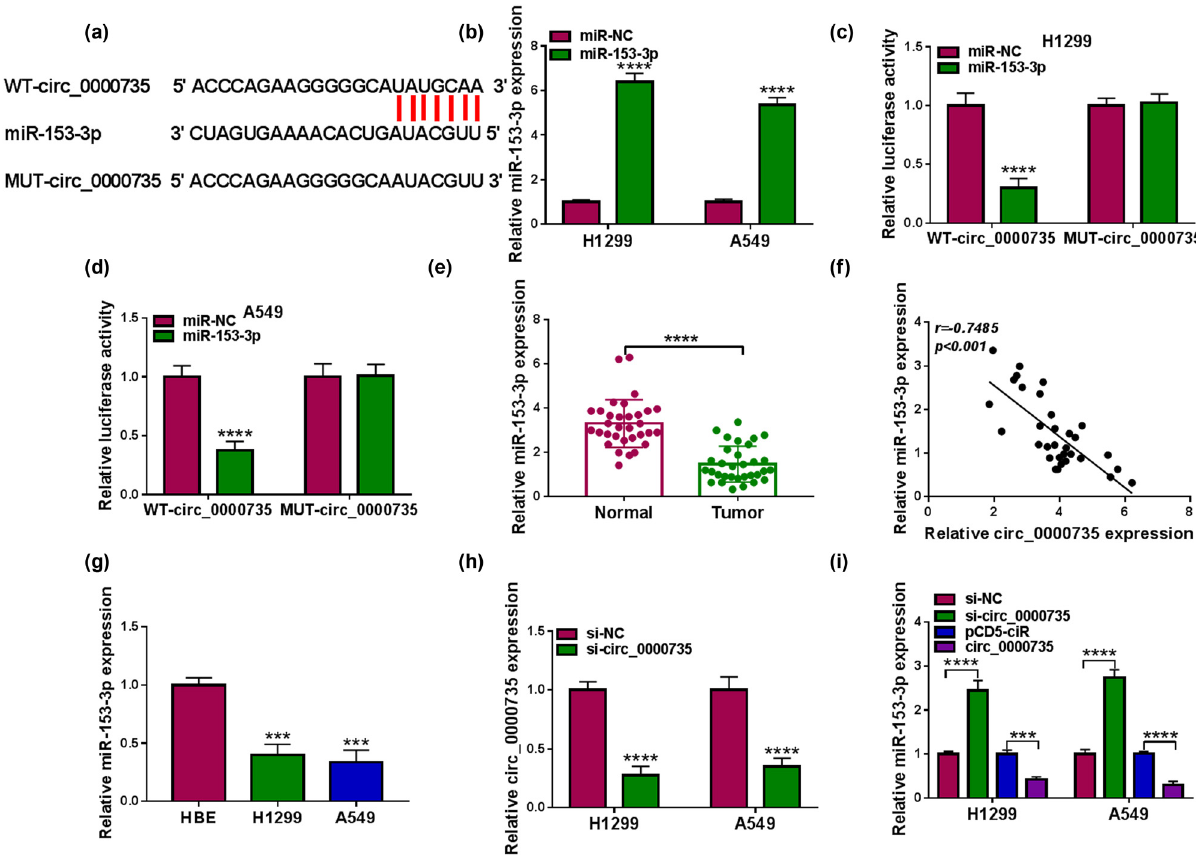
Figure 4: circ_0000735 served as a miR - 153 - 3p decoy. ( a ) Representative sequence alignment of circ_0000735 with miR - 153 - 3p. ( b ) RT - qPCR analysis of the transfection e ffi ciency of miR - 153 - 3p mimic ( n = 3 ) . ( c and d ) Analysis of the luciferase activities of the WT - circ_0000735 and MUT - circ_0000735 reporters in NSCLC cells with miR - 153 - 3p mimic or miR - NC by dual - luciferase reporter assays ( n = 3 ) . ( e ) Evaluation of miR - 153 - 3p in NSCLC tissues ( n = 32 ) using RT - qPCR. ( f ) Correlation of circ_0000735 and miR - 153 - 3p in NSCLC tissues was analyzed by Pearson ’ s correlation analysis. ( g ) Detection of miR - 153 - 3p in NSCLC cells using RT - qPCR ( n = 3 ) . ( h ) Analysis of the interference e ffi ciency of si - circ_0000735 using RT - qPCR ( n = 3 ) . ( i ) Impacts of circ_0000735 inhibition and overexpression on miR - 153 - 3p expression were assessed using RT - qPCR ( n = 3 ) . *** P < 0.001 and **** P <